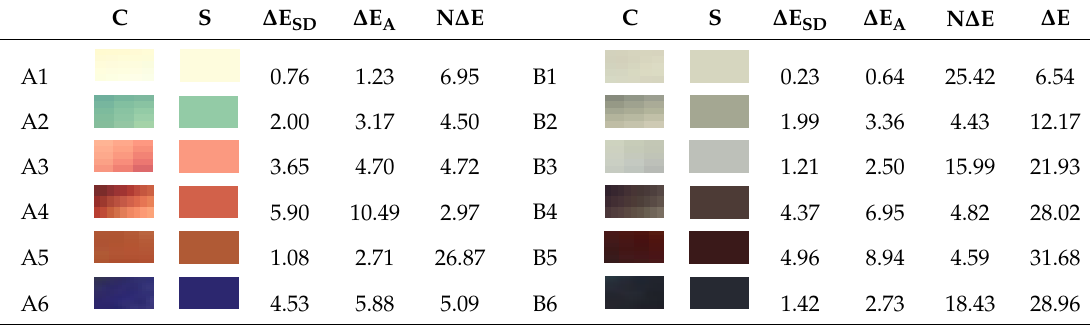
Table 1. Calculation results of contrasting blocks and standard blocks.